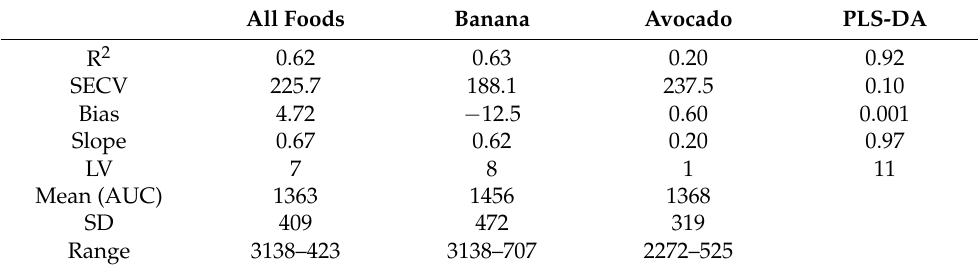
Table 1. Descriptive statistics, partial least squares regression cross validation statistics for the prediction of satiety in saliva samples, and the PLS-DA cross validation statistics for the classification of saliva as low or high satiety. All Foods Banana Avocado PLS-DA R 2 0.62 0.63